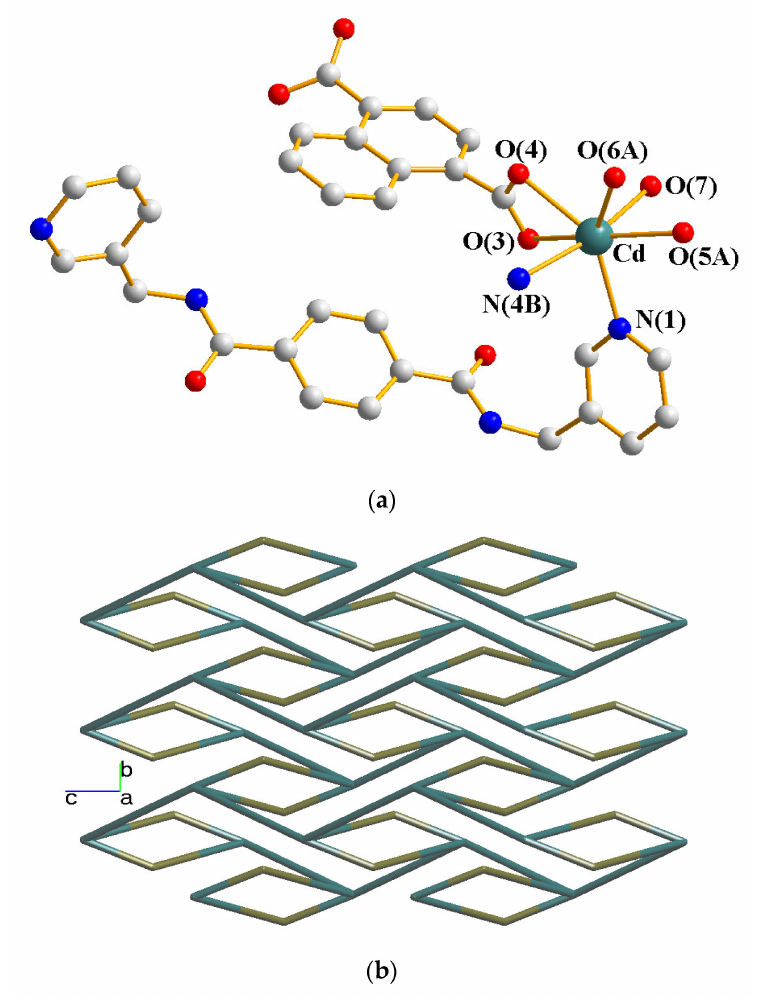
Figure 8. ( a ) The coordination environment of the Co(II) ion in 7 . Symmetry transformations used to generate equivalent atoms: (A) x, − y + 3/2, z + 1/2; (B) –x + 1, − y + 1, − z + 1. ( b ) A drawing showing the 2,4L1